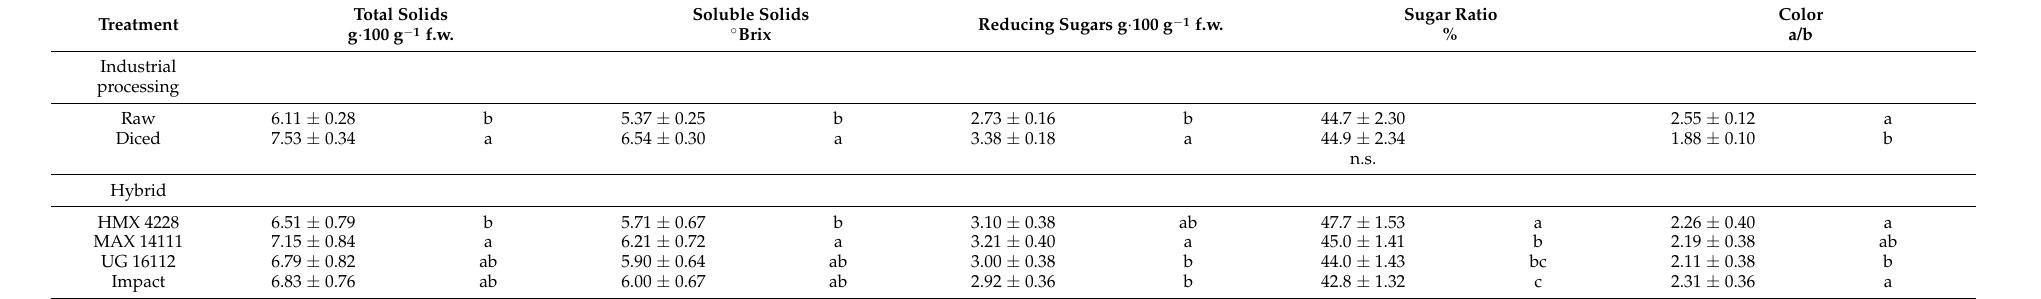
Table 3. Quality features of tomato fruits as affected by industrial processing and